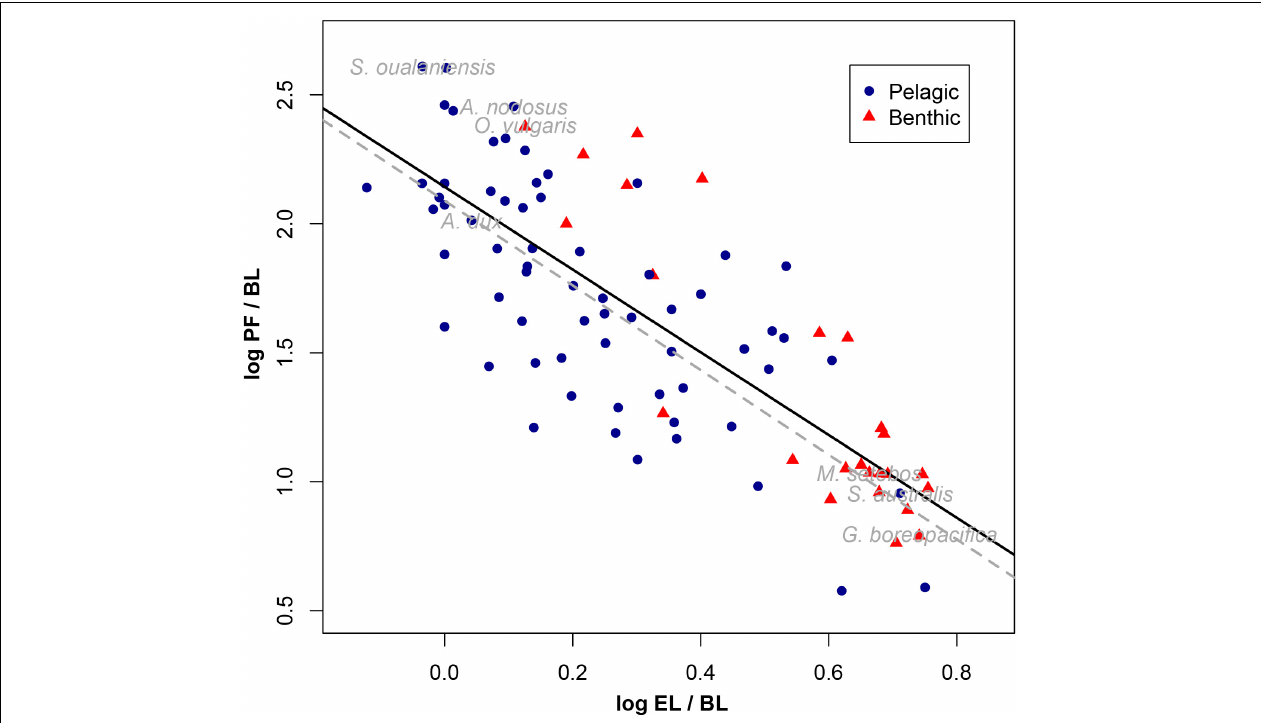
FIGURE 3 | Relationships between reproductive traits of 90 cephalopod species corrected by body length. Dashed lines represent regressions from PGLS. Solid lines represent regressions from